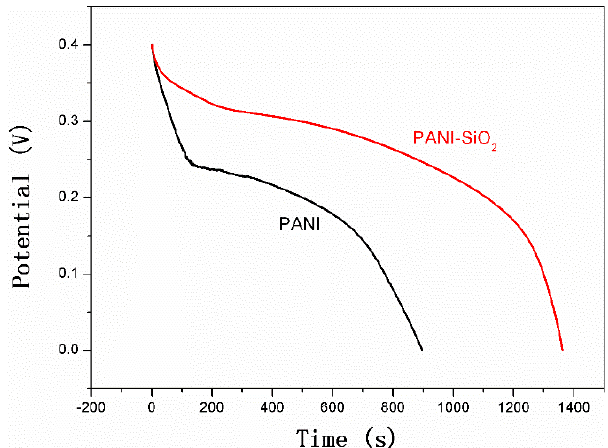
Figure 8. Galvanostatic charge/discharge test results of bulk PANI and PANI-SiO 2